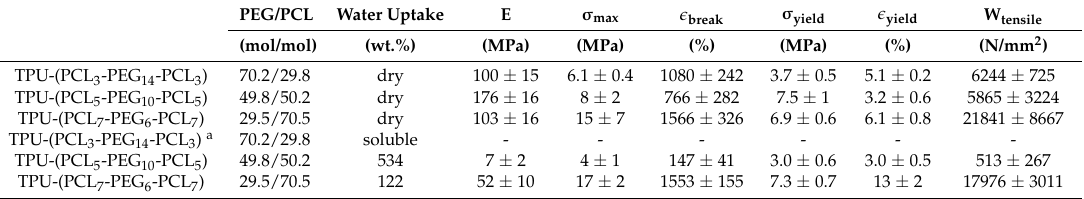
Figure 6. Stress-strain curves of the different TPU-(PCL- b -PEG- b -PCL) multi-block copolymers with different compositions: ( a ) Experiments conducted using dry specimens and ( b ) experiments conducted using wet specimens. The water uptake of TPU-(PCL 5 -PEG 10 -PCL 5 ) was 534%, the water uptake of TPU-(PCL 7 -PEG 6 -PCL 7 ) was 122%. Table 4. Tensile properties of TPU-(PCL- b -PEG- b -PCL) multi-block copolymers in the dry and in the wet state. ( n = 5, average ±